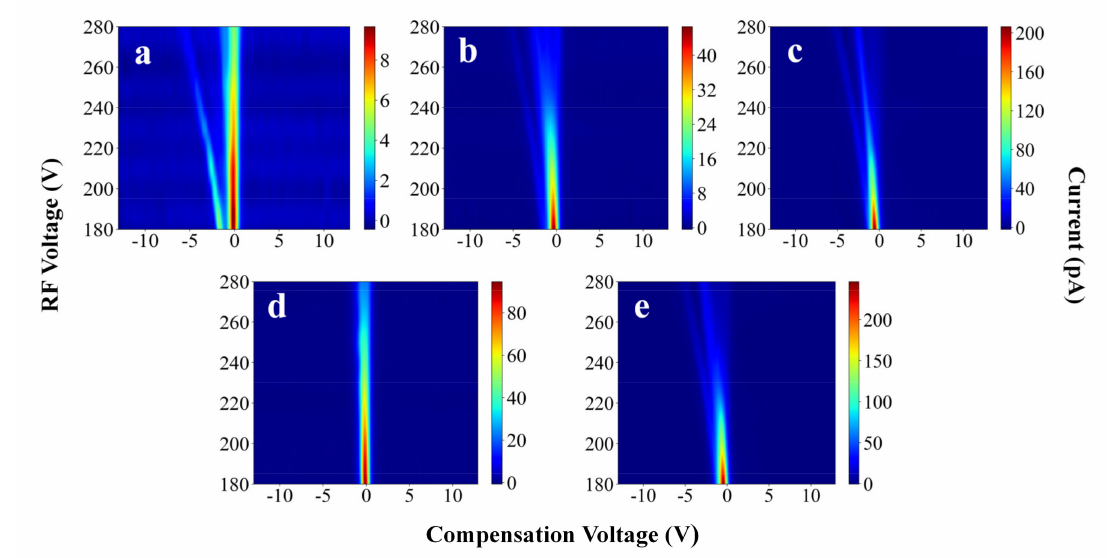
Figure 3. FAIMS spectra of pure compounds: ( a ) ethanol, ( b ) ethyl acetate, ( c ) acetone, ( d ) 4-methyl-2-pentanone, and ( e ) 2-butanone.